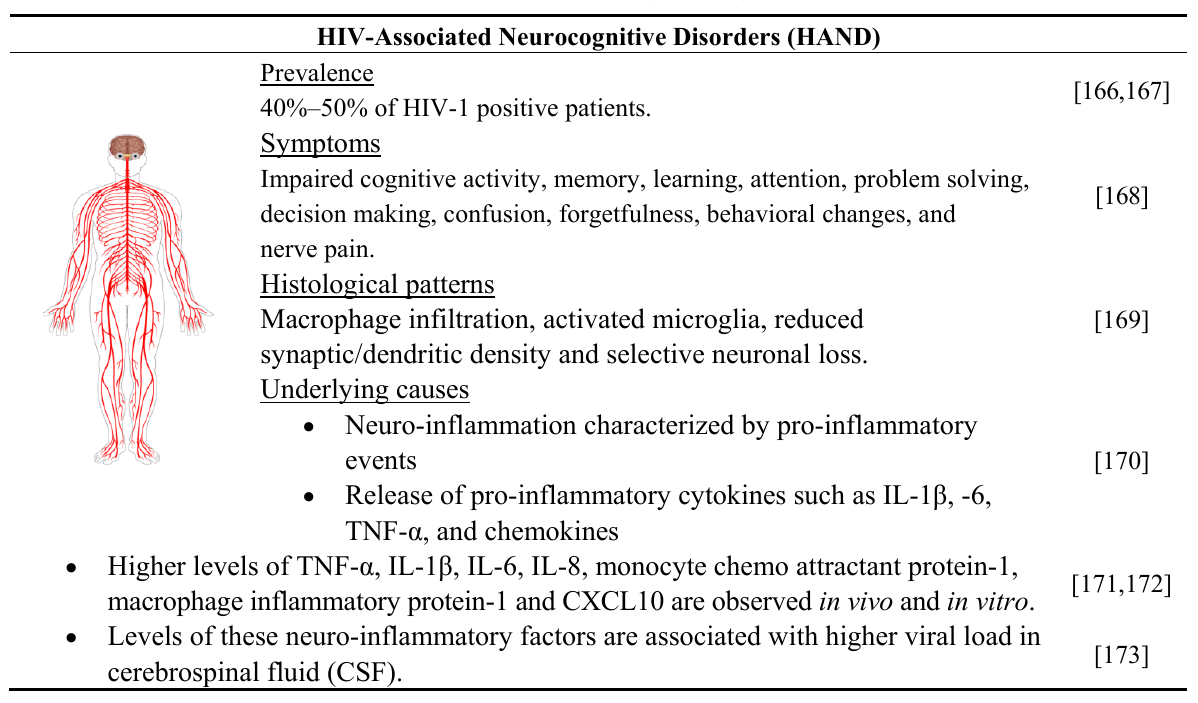
Table 2. HIV related